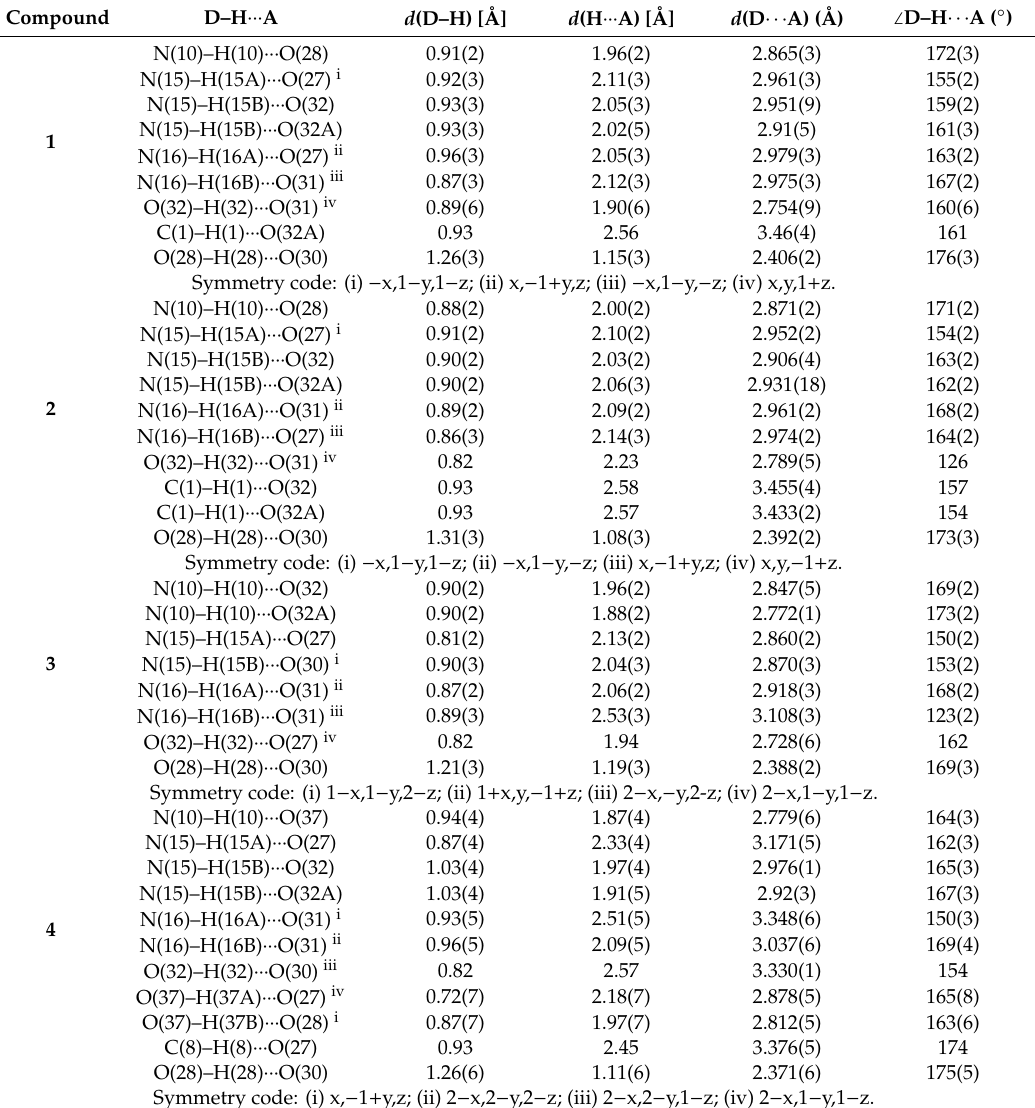
Table 2. Hydrogen bonds geometry for compounds